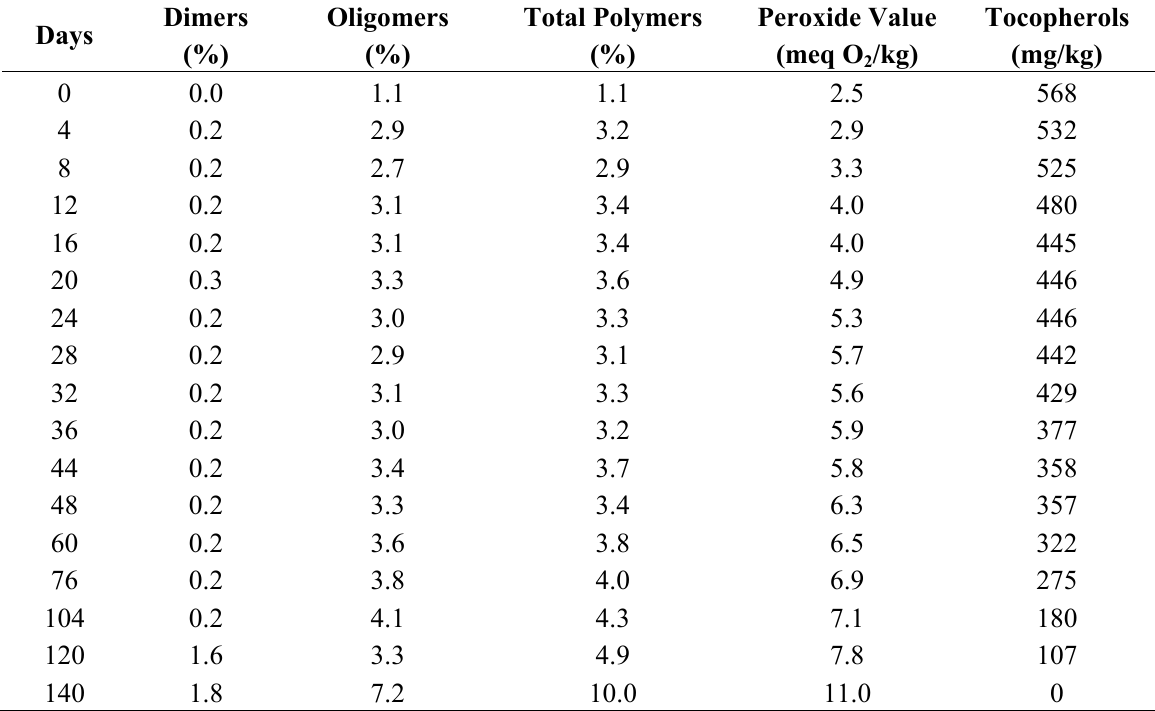
Table 3. Oxidation of Tonalin oil at 25 °C.